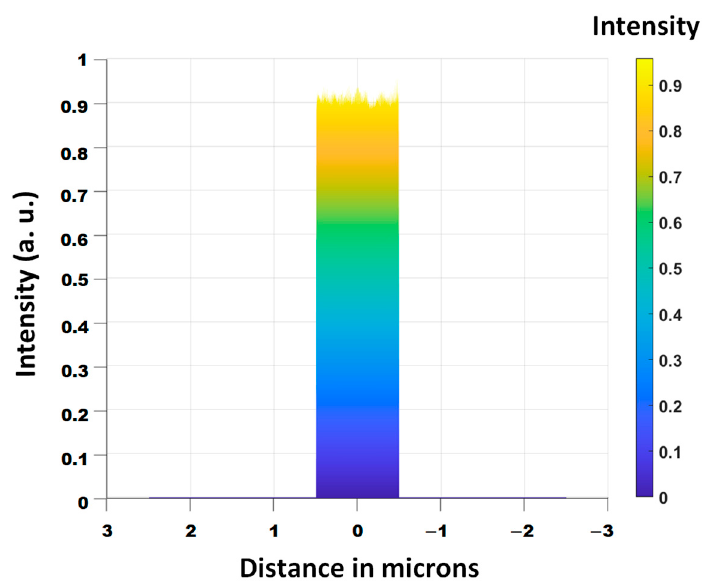
Figure 5. Plot of the top-hat beam obtained after the addition of the random noise to the optical element.